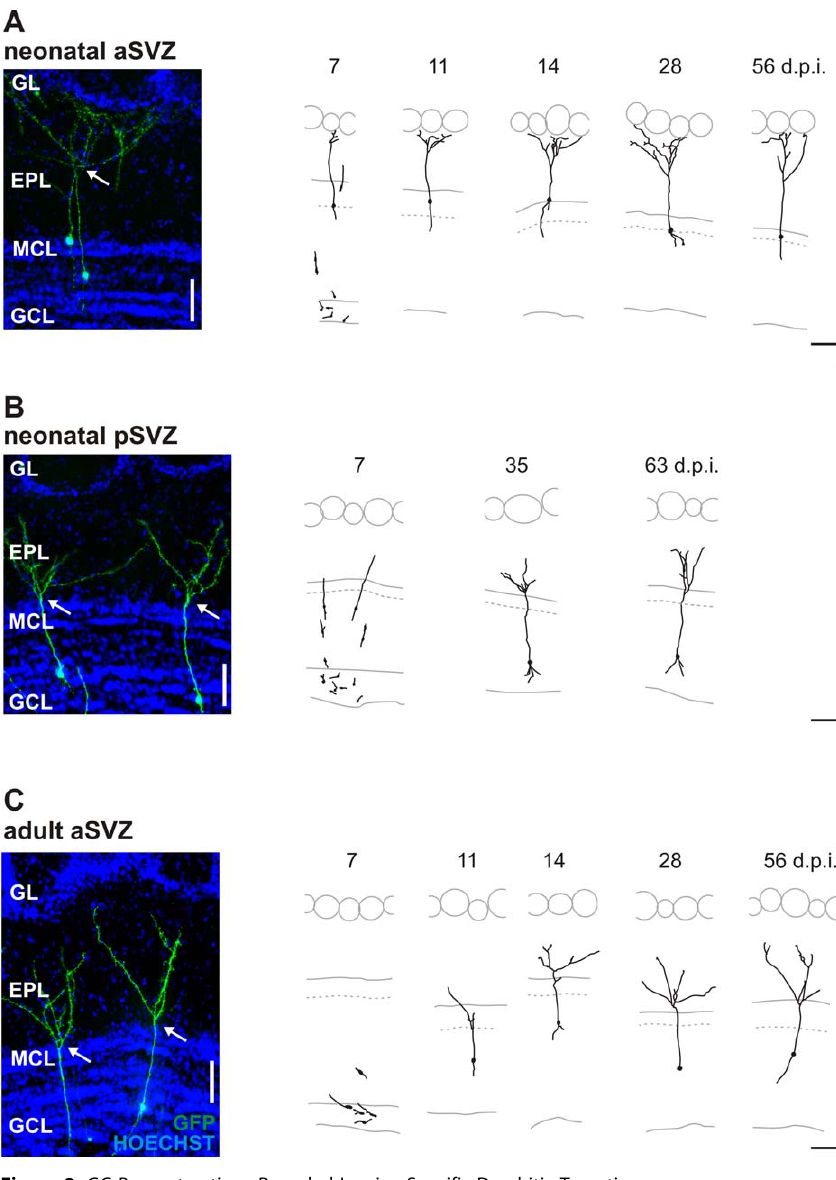
Figure 2. GC Reconstructions Revealed Lamina-Specific Dendritic Targeting (A) Different types of GCs were generated from distinct precursors in the SVZ labeled with a GFP (green) expressing retrovirus. Hoechst 33258 (blue) revealed the anatomical layers. Precursors infected in the aSVZ of neonatal rats gave rise to GCs whose first dendritic branching point (arrow) was in the superficial EPL. (B) Infection of precursors in the pSVZ of neonatal rats generated GCs whose first dendritic branching point was the deep EPL (arrow). (C) Precursors that were infected in the aSVZ of adult rats generated GCs with apical dendrites that branched in the deep layers of the EPL (arrow). The morphological characteristics of newly generated GCs were established soon after their differentiation and maintained throughout maturity. Time course of GC maturation in the olfactory bulb for precursors from neonatal aSVZ (A), neonatal pSVZ (B), and adult aSVZ (C) at different time points (in d.p.i.) is shown. All bars indicate 100 l m.